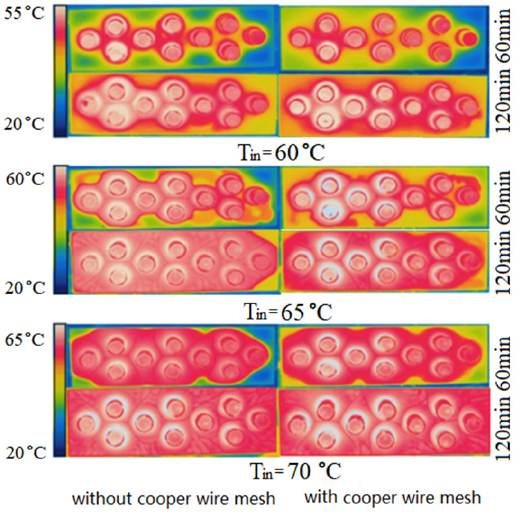
Figure 11. Experimental photos of temperature fields on PCM-2 upper surface.